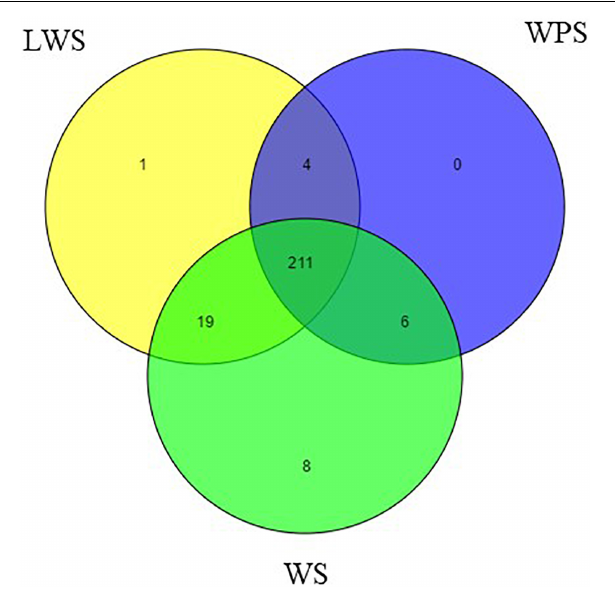
FIGURE 1 | Venn diagram representing the distribution of miRNA in the WS, LWS, and WPS stages of Bactrocera dorsalis .